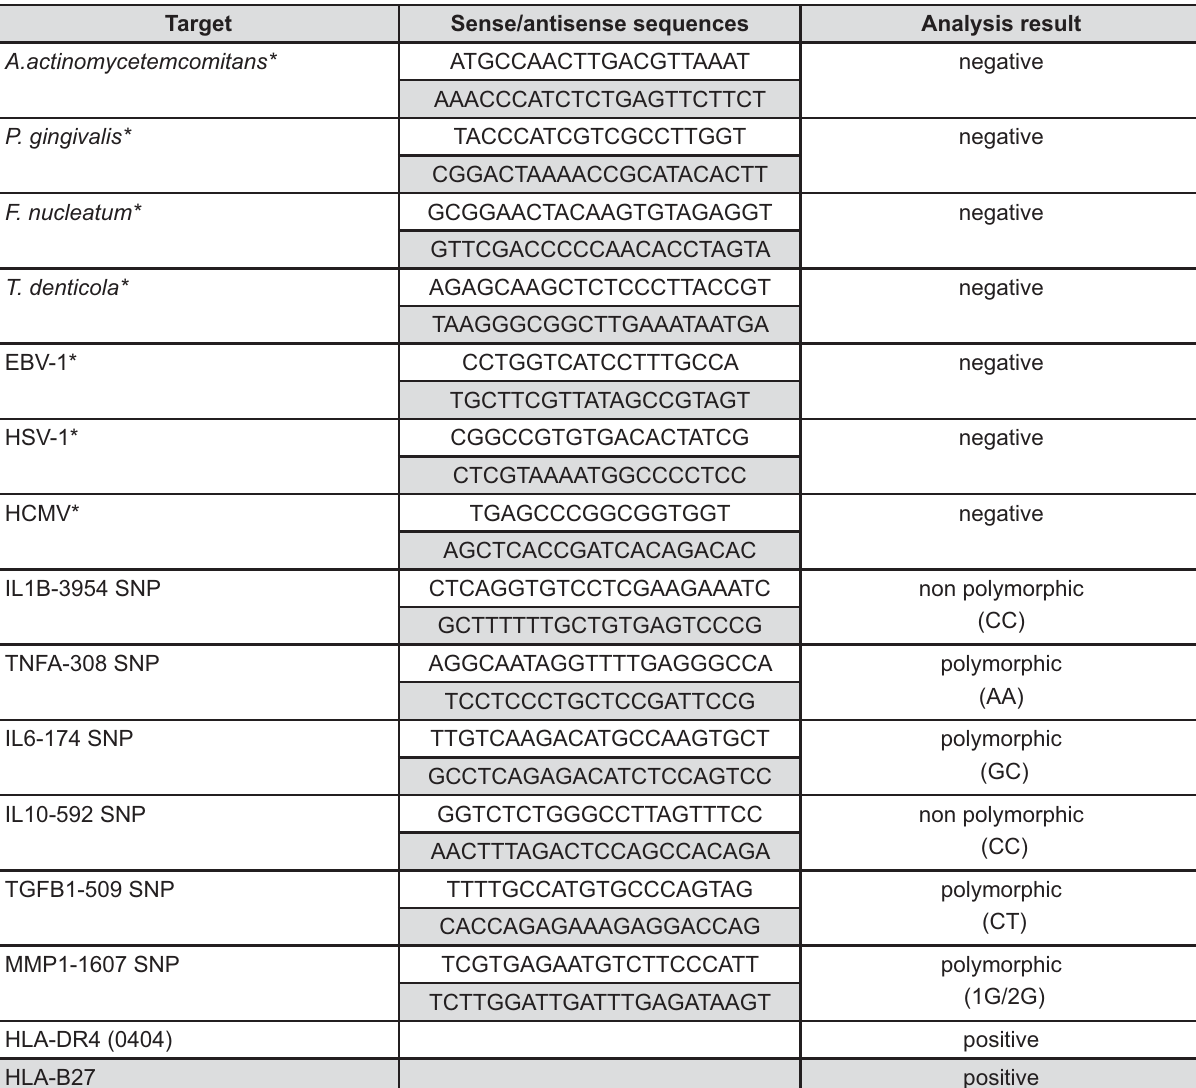
Figure 4- Primer sequences and results from the genetic and microbiological analysis. *Results are representative of both inferior and superior arches